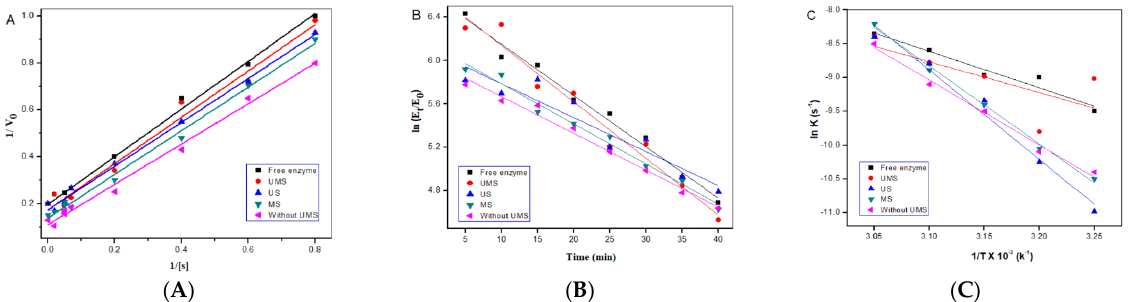
Figure 6. ( A ) Lineweaver–Burk plots, ( B ) relationship between ln (Et/E0) and reaction time, and ( C ) Arrhenius plots of ln (k) and 1/T.